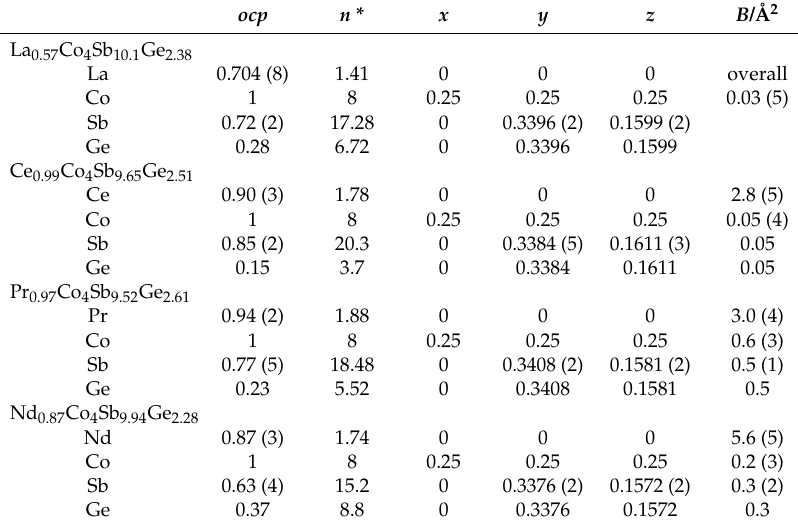
Table 3. Structural parameters ocp , n , x , y , z , and B /Å 2 of the Ge-substituted cobalt antimony skutterudite